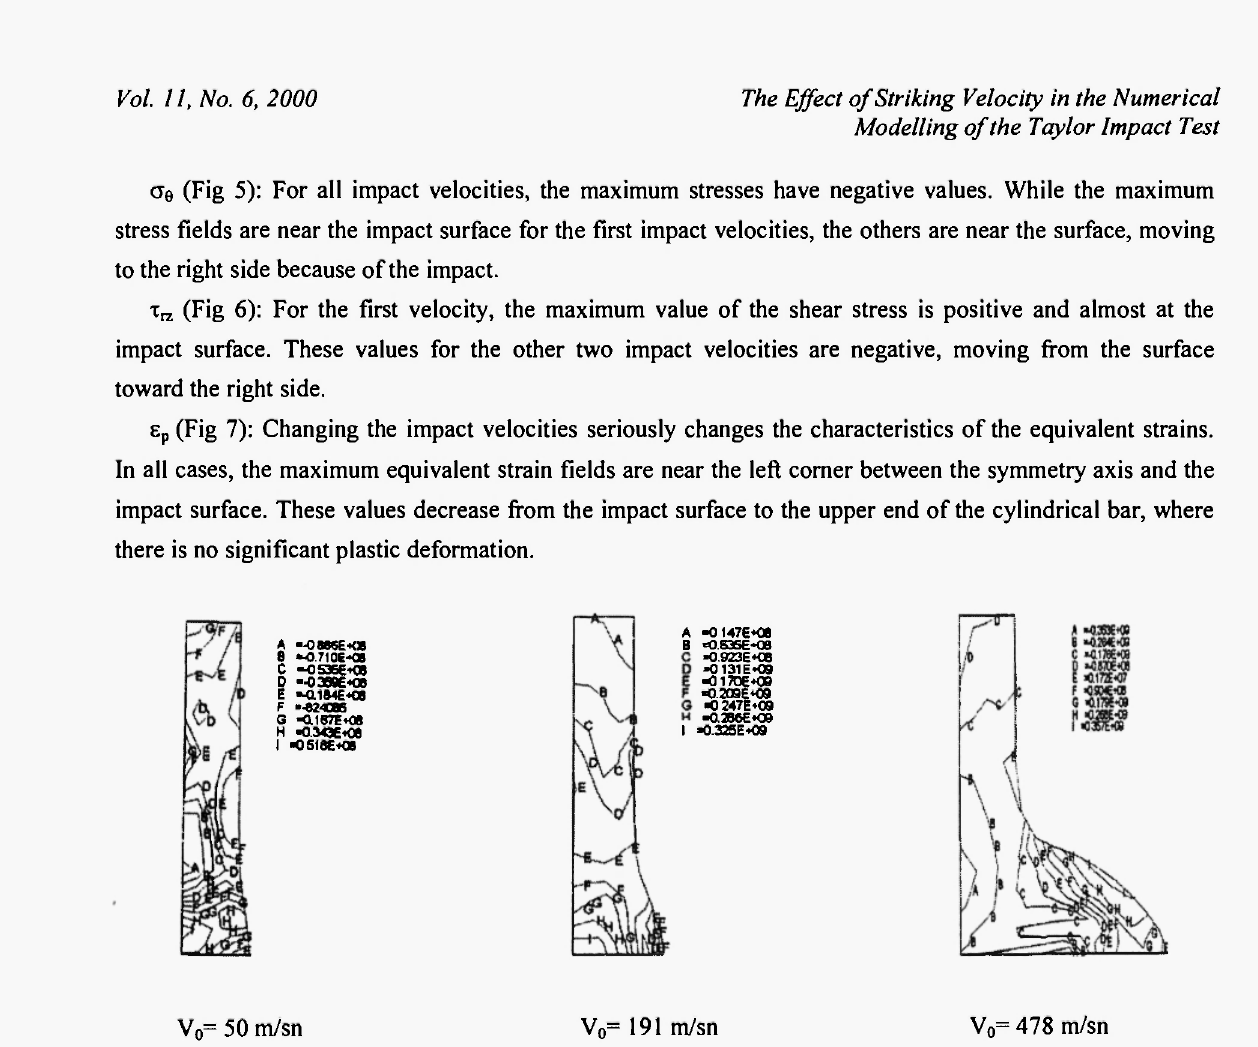
Fig. 3: Comparison of the computed radial stresses σ Γ for all velocities